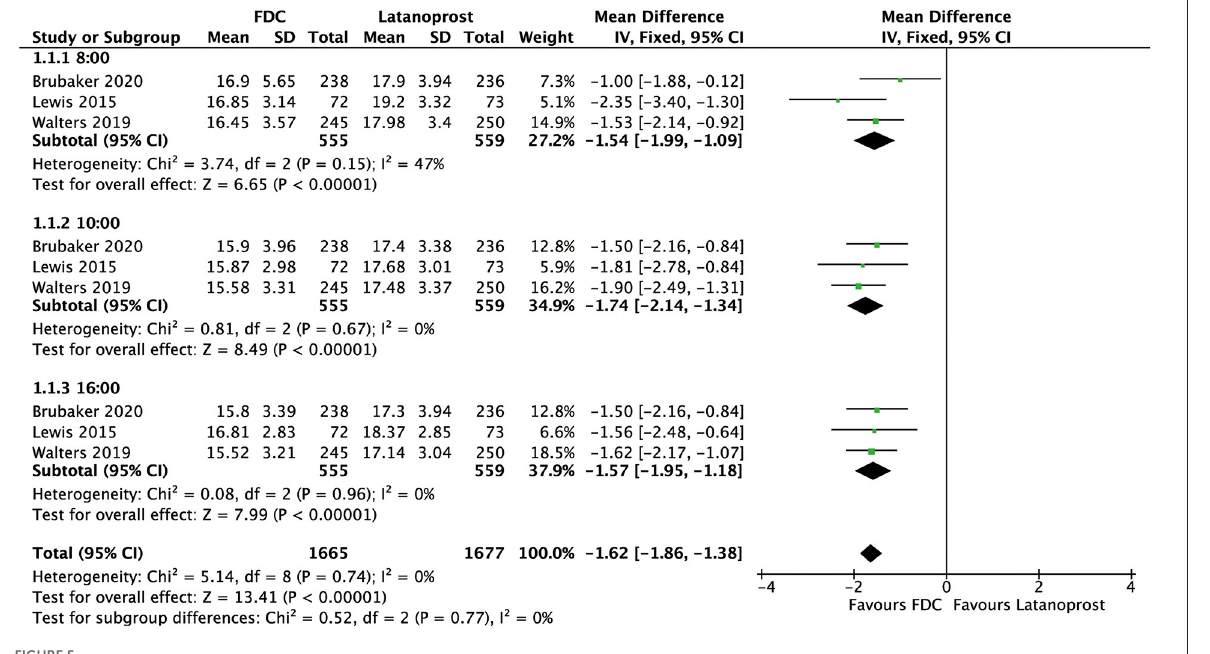
FIGURE5 Forest plot of WMD of IOP at 3 time points (8:00a.m., 10:00a.m., 4:00 p.m.) associated with FDC vs.